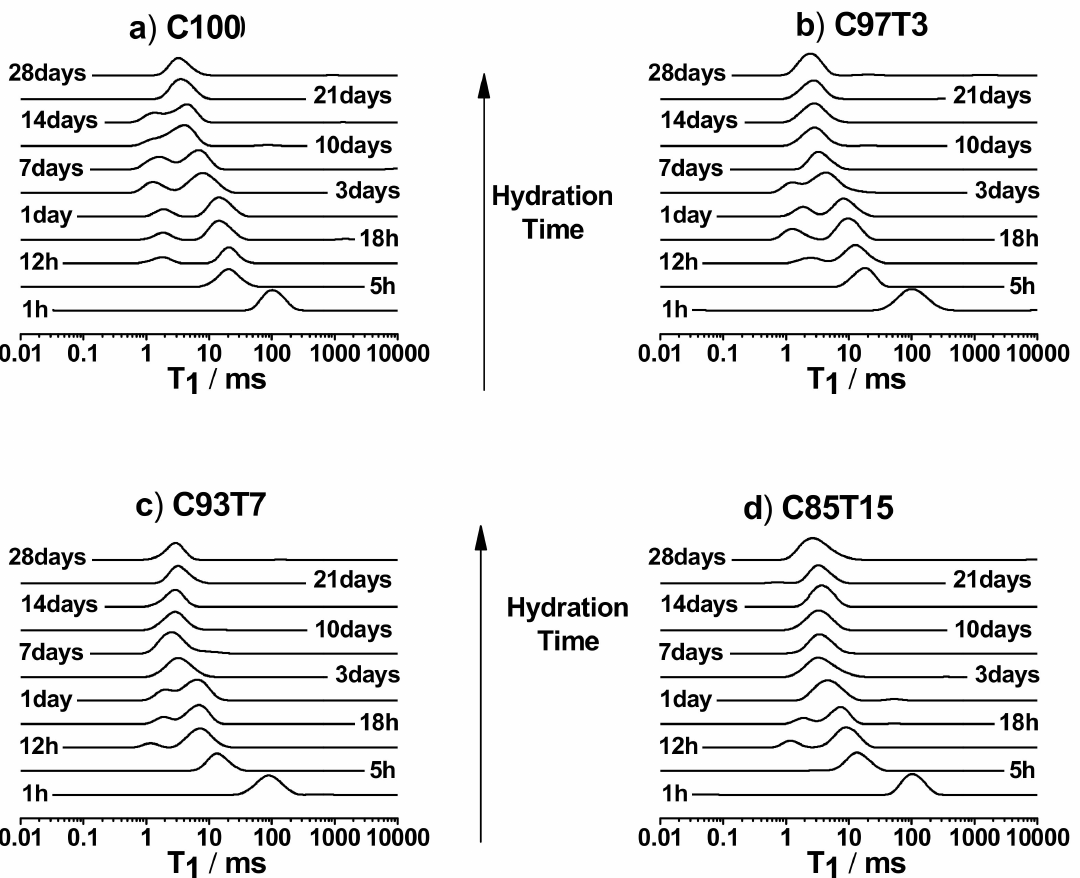
Figure 5. NMR spin–lattice relaxation T 1 distribution profile versus hydration time obtained from the inverse Laplace transform of the NMR data for ( a ) C100, ( b ) C97T3, ( c ) C93T7 and ( d ) C85T15, samples. Note the change of the T 1 profile from one, two, to one component at short, intermediate and long hydration times,